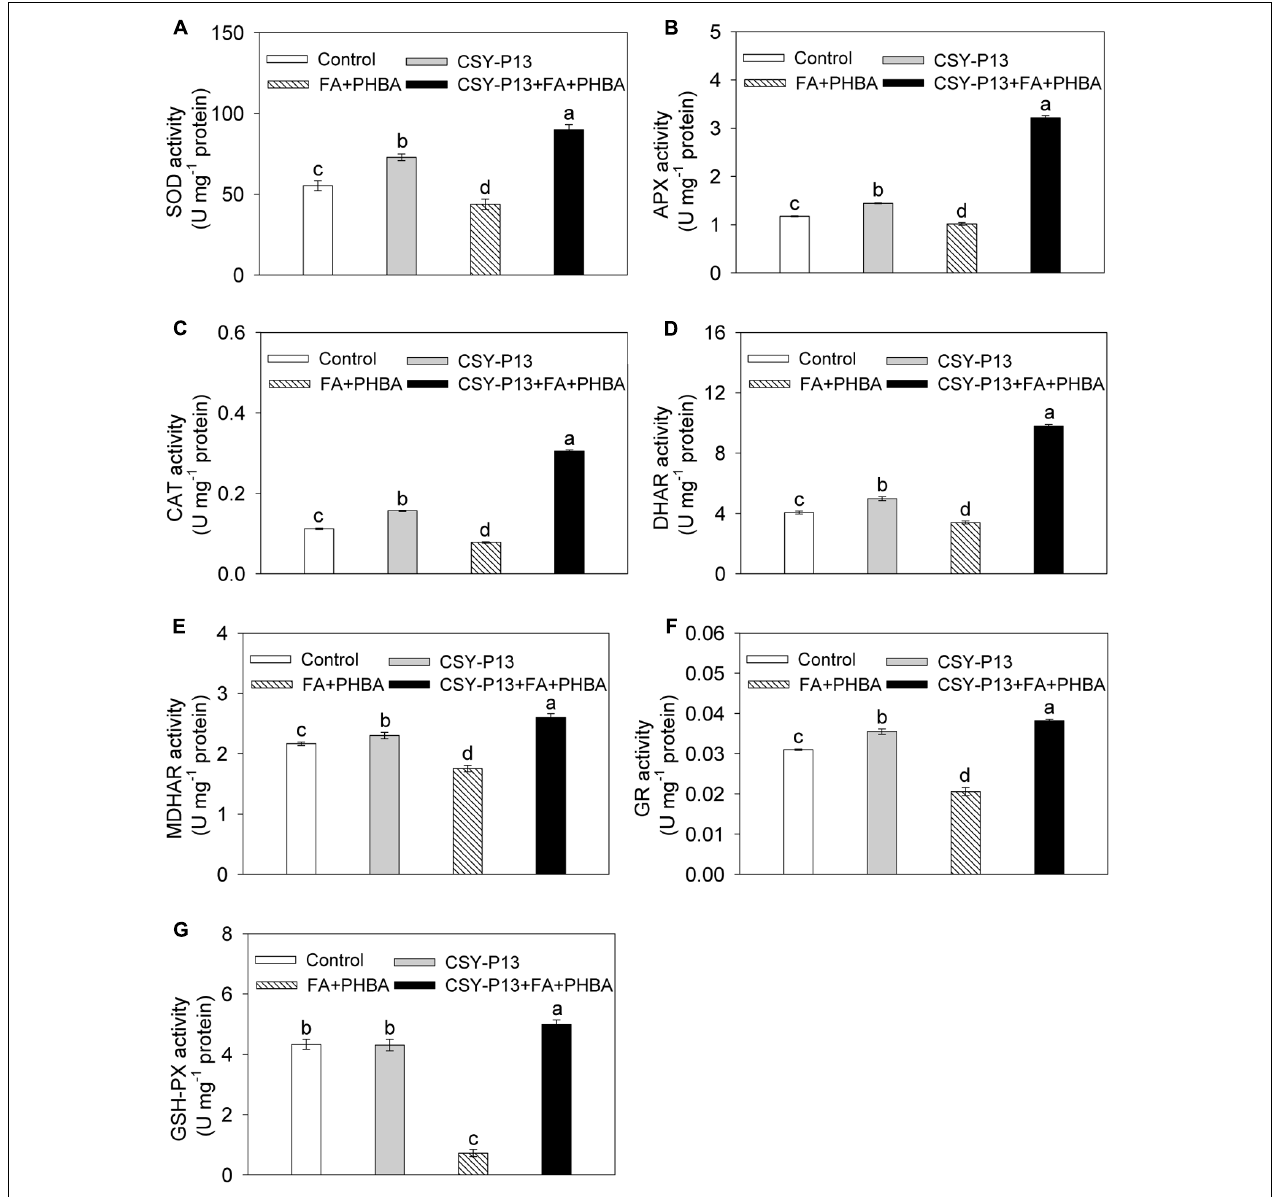
FIGURE 5 | Effects of CSY-P13 and the mixture of FA and PHBA on SOD (A) , APX (B) , CAT (C) , DHAR (D) , MDHAR (E) , GR (F) , and GSH-Px (G) activities in cucumber leaves. Bars represent standard errors of three biological replicates. Values with the different letters are significantly different at P < 0.05 by LSD test using SPSS for Windows 22.0 software (IBM Corp., Armonk, NY, United